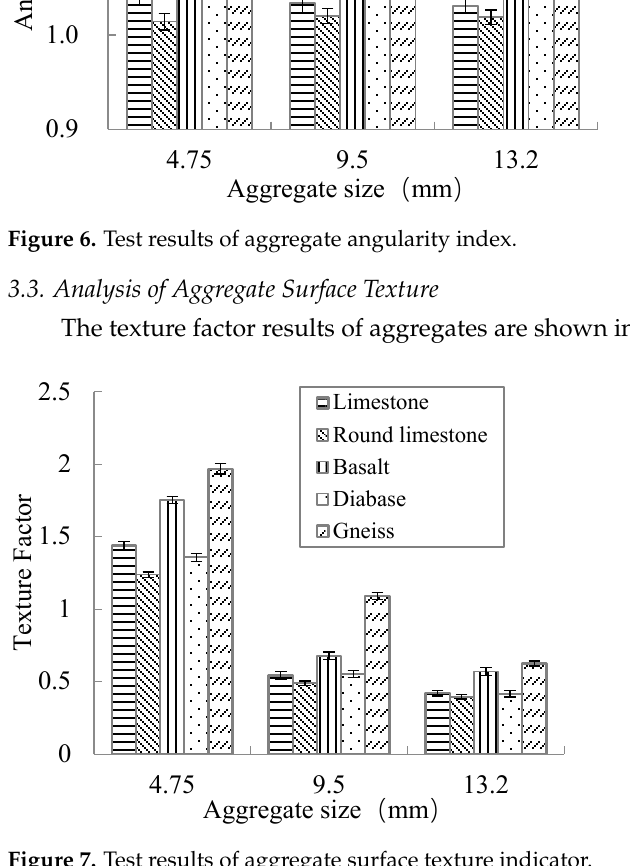
Figure 7. Test results of aggregate surface texture indicator.